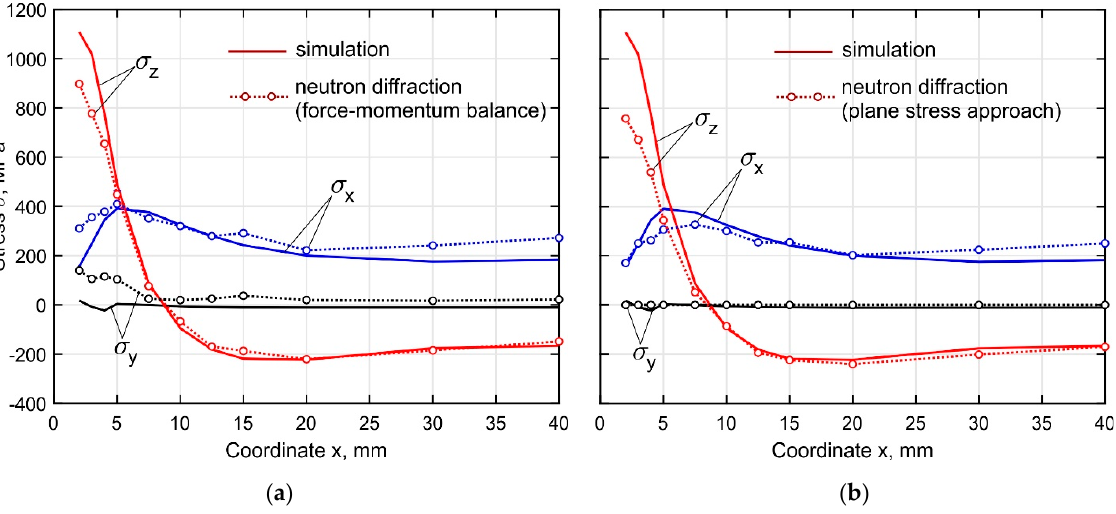
Figure 15. Comparison of the numerically obtained and experimental measured curves of the residual stresses components along the length of the buildup at a distance of 2 mm from the substrate. ( a ) force-momentum balance approach. ( b ) plane stress